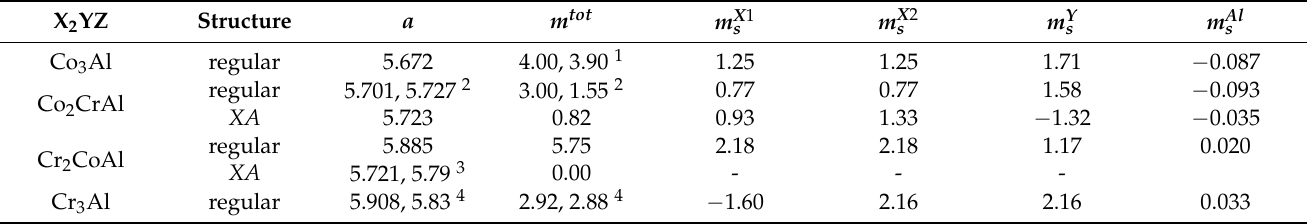
Table 1. Calculated lattice constant a (Å), total spin magnetic moments ( m tot ) ( µ β /f.u.) and atomic ( m s ) ( µ β /atom) spin magnetic moments of all considered Co 3 − x Cr x Al Heusler